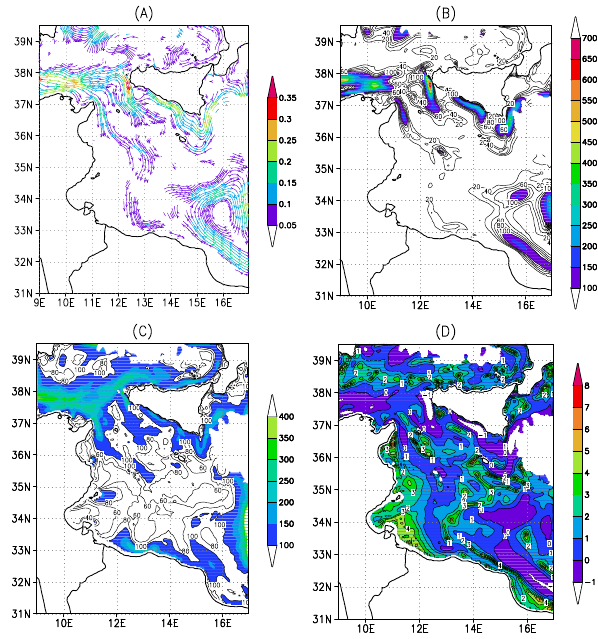
Fig. 3. Maps of mean flow (panel A , [ms − 1 ]), MKE (panel B , [cm 2 s − 2 ]), EKE (panel C , [cm 2 s − 2 ]) and the logarithmic ratio EKE over MKE (panel D ) averaged on the period 2008-2010 and vertically integrated from surface to 5m depth. In panel A the minimum velocity current represented is 5cms − 1 . In panels B and C areas with MKE and EKE larger than 100cm 2 s − 2 are shaded while the contour interval is 50cm 2 s − 2 . In panel D the contour interval is 1.